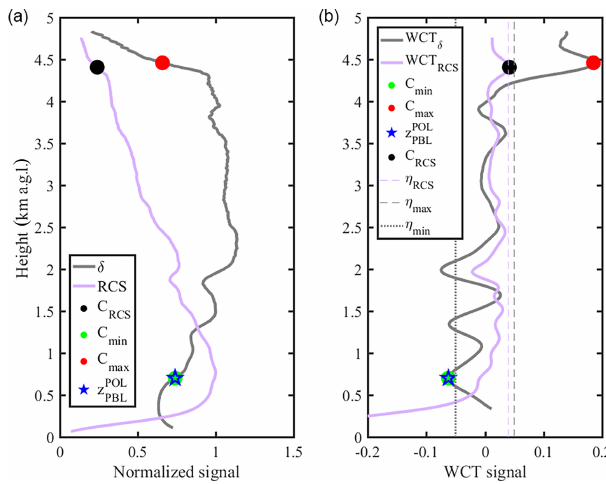
Figure 5. Normalized RCS and δ profiles (a) . WCT of the RCS, δ and thresholds η min ( − 0.05), η RCS (0.05) and η max (0.04) (b) at 21:30UTC 16 June 2013. C RCS , C min and C max candidates and z POL are shown in both PBL